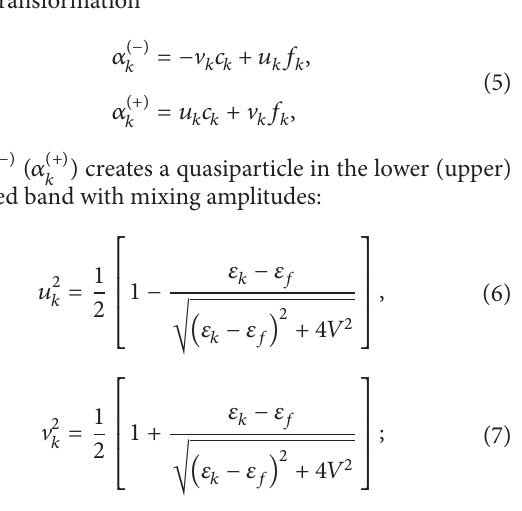
Figure 1: Momentum distribution functions of the conduction and 𝑓 electrons in the noninteracting case ( 𝑈 = 0 ). The solid and dotted lines are obtained from (6) and (7), 𝜀 𝑓 respectively. The symbols (bullet and red square) denote the DMRG results for 𝐿 = 50